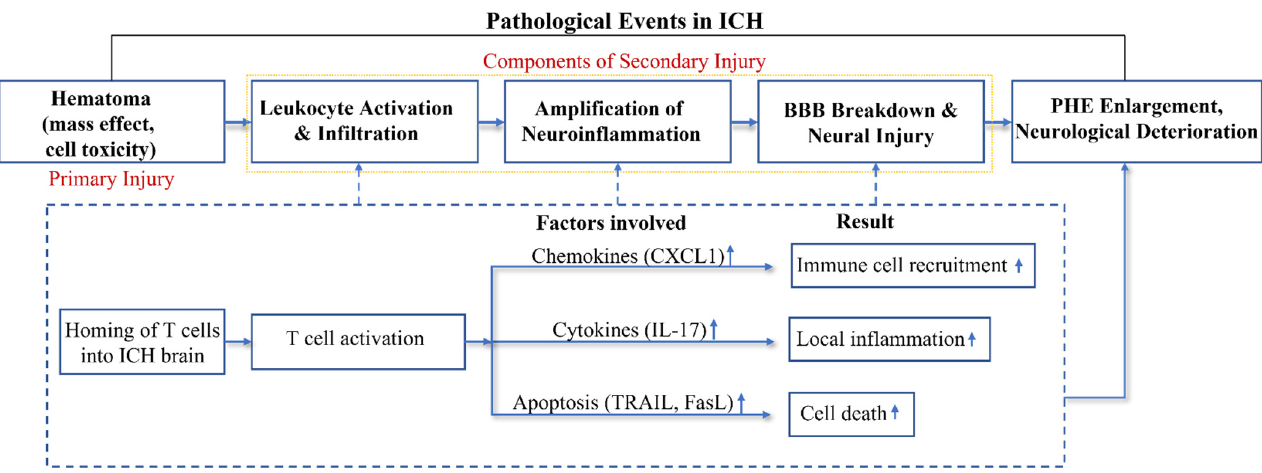
Figure 1. Acute T cell actions in ICH. After onset of ICH (hours to days), CD4+ T cells migrate to the brain, where they operate through antigen-dependent and/or antigen-independent mechanisms. The infiltrating CD4+ T cells may harm brain tissue through the release of pro-inflammatory cytokines (IL-17) and the promotion of local inflammation (a). They also secrete chemokines such as CXCL1 that can recruit circulating neutrophils into PHE (b). Their expression of the cell apoptosis ligands can induce apoptosis of intrinsic brain cells that express cognate apoptotic receptors (c). Such events (a–c) enhance neurovascular inflammation and exacerbate BBB disruption, leading to PHE expansion and neurological deterioration.